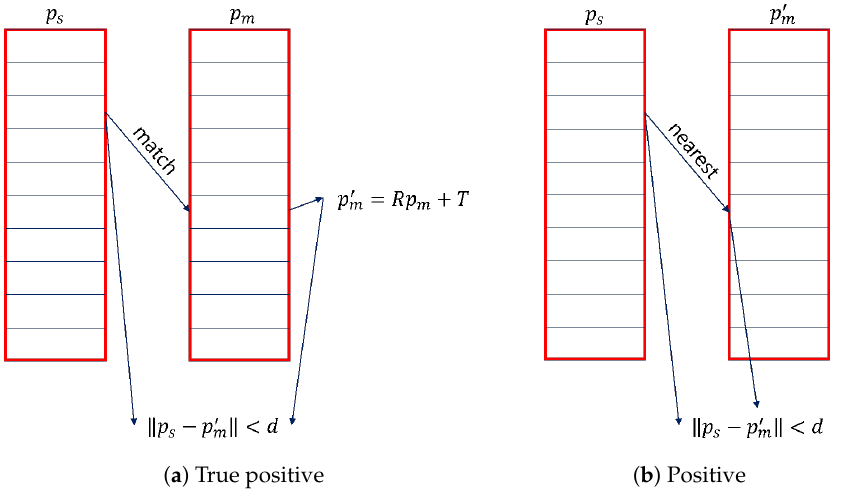
Figure 11. True Positive and Positive.